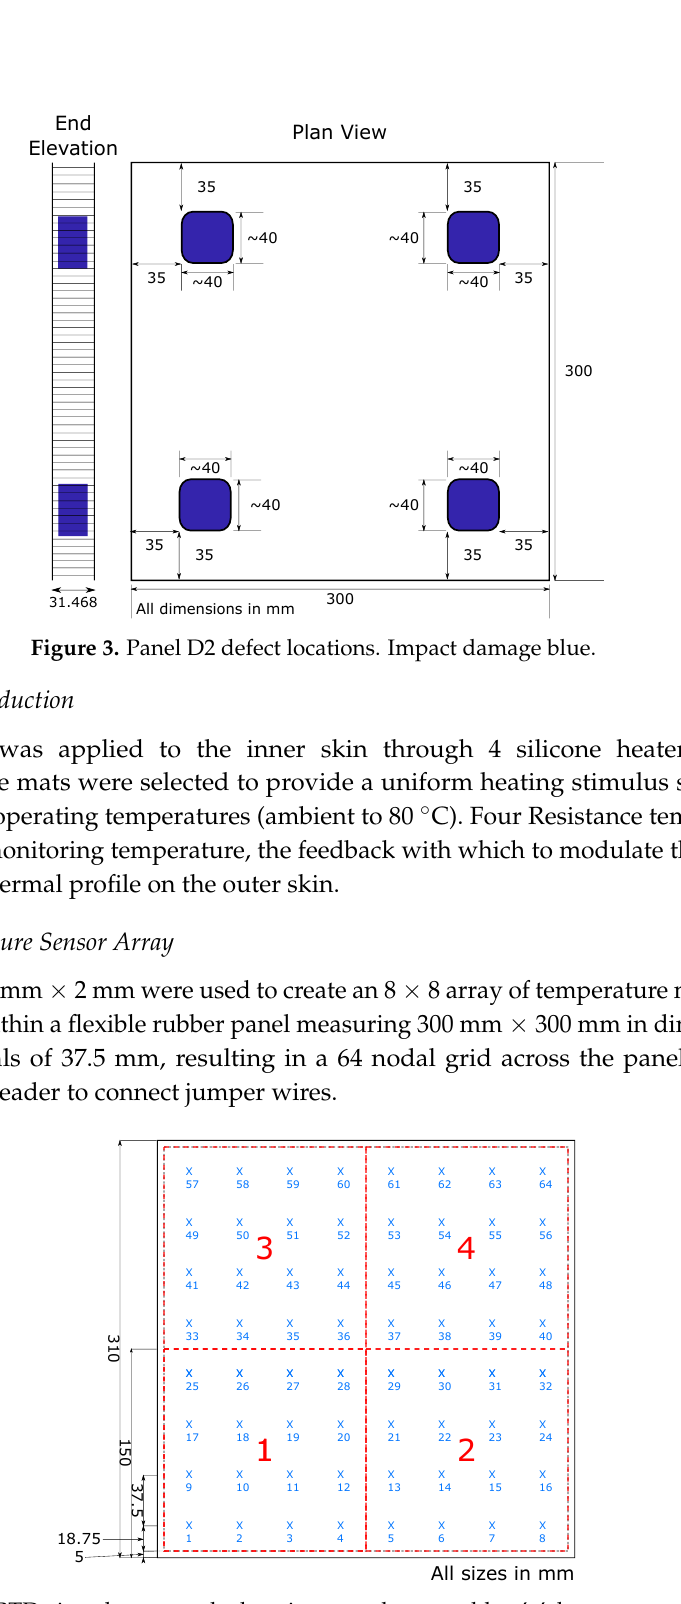
Figure 4. The 8 × 8 RTD airpad array probe locations are shown as blue ’x’, heat zones are shown in red dashed